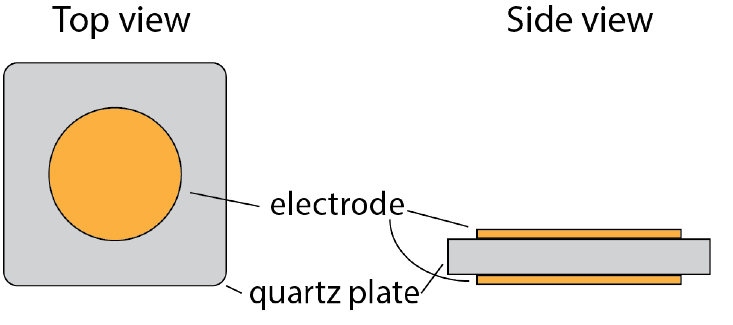
Figure 2. Basics structure of